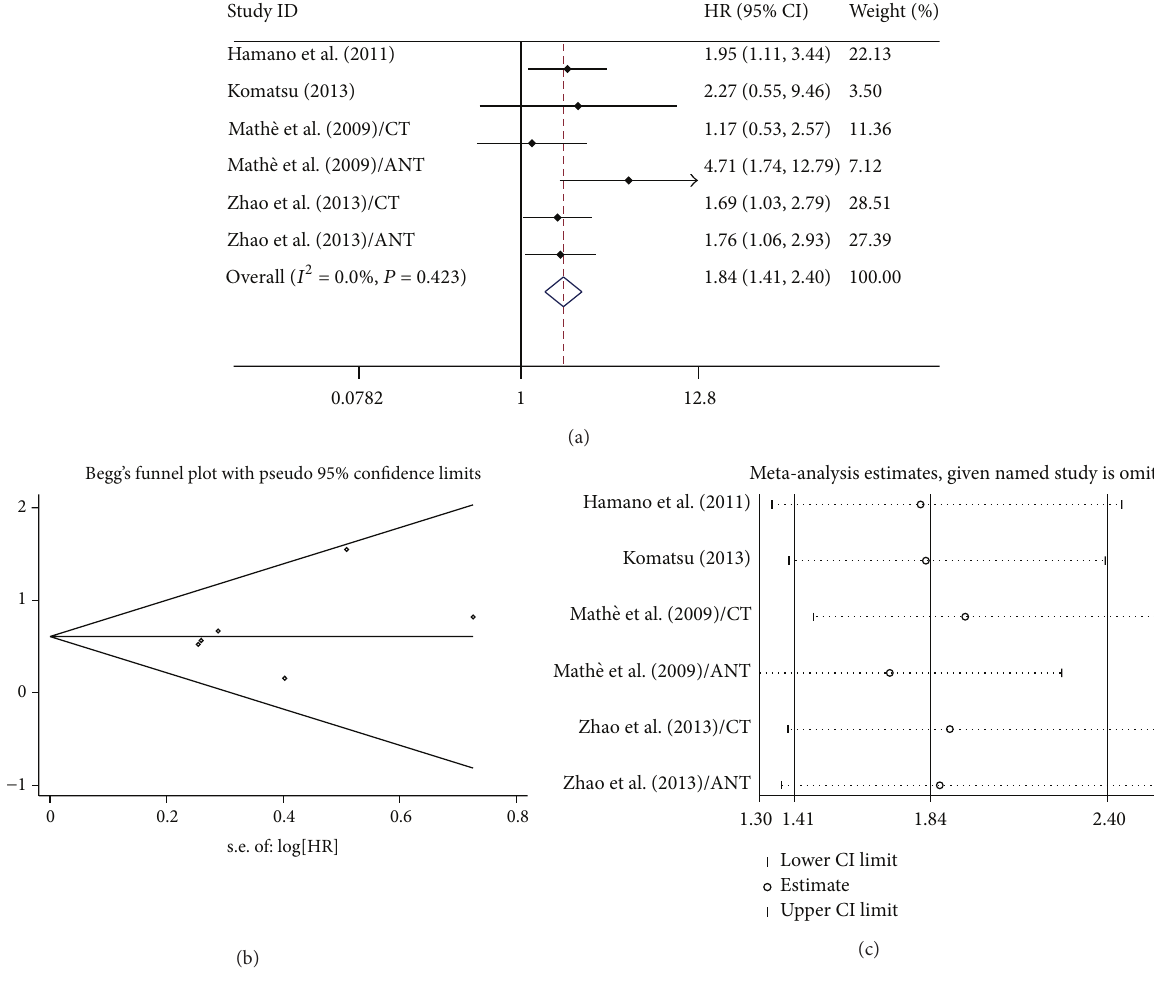
between miR-21/375/145 expression level and prognosis of EC patients. Third, a clear definition should be made about the cutoff value of miRNAs level for outcomes in